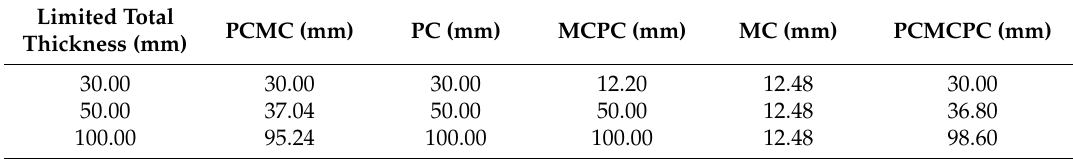
Table 7. Summarized actual total thickness with the different presupposed limited total thickness.